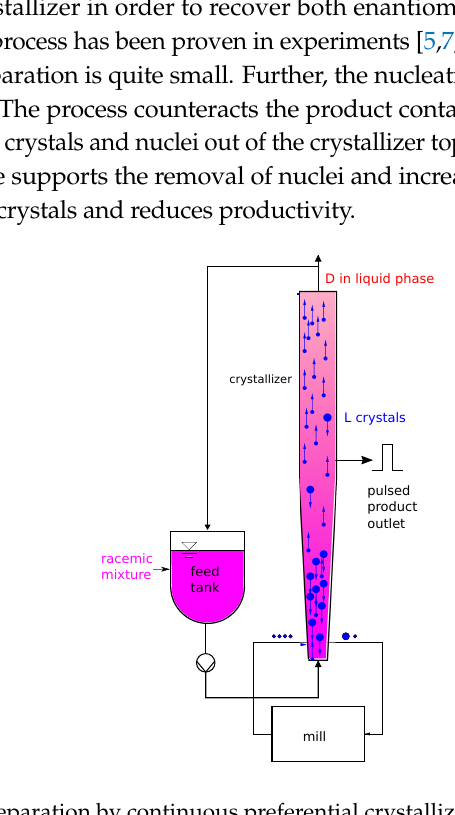
Figure 1. Enantiomer separation by continuous preferential crystallization taking place in a conically shaped crystallizer. An over-saturated racemic liquid mixture is fed to the crystallizer, which was seeded with desired L crystals before. Under suitable conditions, L crystals grow selectively, resulting in a pure crystal phase containing only the L